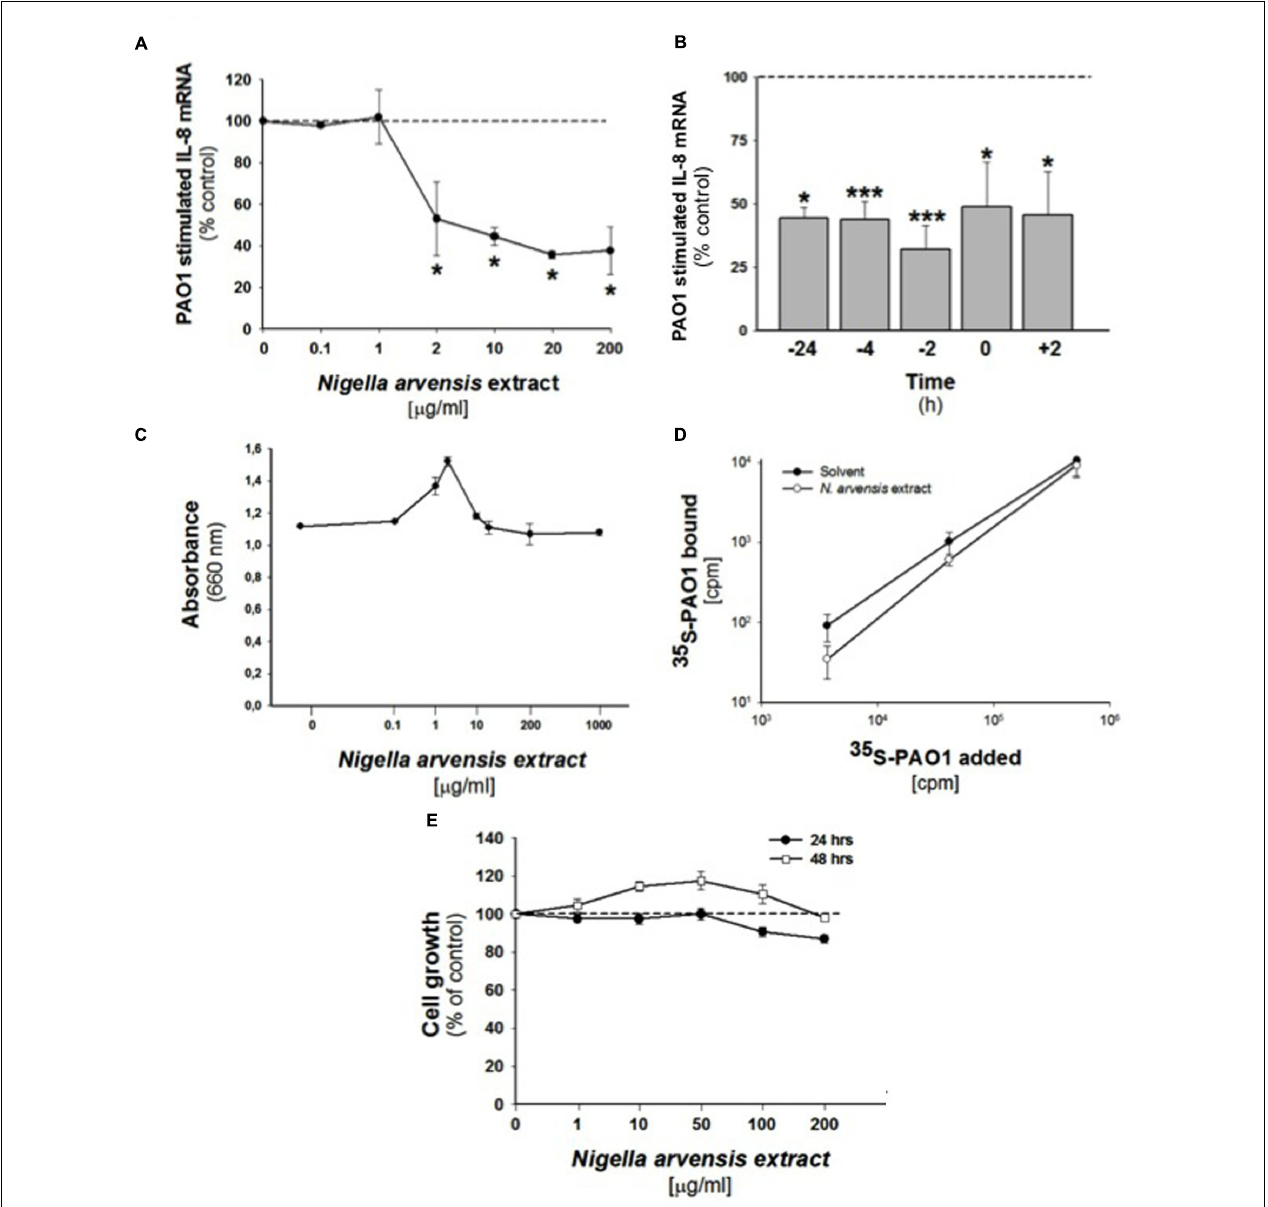
FIGURE 2 | Effect of N. arvensis extracts in IB3-1 cells. (A) Effect of N. arvensis extracts on IL-8 mRNA expression in IB3-1 cells. IB3-1 cells were treated with the chloroform extract (solved in EtOH/DMSO 95/5) (A) at different concentrations (0.1–200 µ g/ml) for 16 h before infection with PAO1 (100 CFU/cell) for further 4 h. IL-8 mRNA expression was quantified by qRT-PCR. Expression of IL-8 mRNA was measured by Real-Time qPCR and obtained by comparing the ratio IL-8 and the housekeeping gene GAPDH between non-infected and infected cells. The results are expressed as the % of untreated cells. Data are mean ± SEM of three independent experiments performed in duplicate. Dashed line corresponds to cells treated with solvent alone. (B) Effect of N. arvensis extract in PAO1 infected IB3-1 cells after different incubation times. The N. arvensis extract (10 µ g/ml) was added to IB3-1 cells 24, 4, and 2 h before, simultaneously or 2 h post PAO1 infection (100 CFU/cell). IL-8 mRNA expression was measured as indicated in (A) . Data are mean ± SEM of three independent experiments performed in duplicate. Dashed line corresponds to cells treated with solvent alone. (C) PAO1 growth. Bacteria were cultured overnight at 37 ◦ C in the presence of solvent or ranging doses (0.1–1000 µ g/ml) of N. arvensis extract. Bacterial growth was monitored by absorbance measures at 660 nm. A representative experiment performed in duplicate is shown. (D) Adhesion of PAO1 to IB3.1 cells. 500,000 IB3-1 cells on Petri dishes, in duplicate, were treated for 24 h with 10 µ g/ml N. arvensis extract. Different amounts of 35 S-PAO1, expressed as CFU/well, were added to the wells and incubated as described in section “Materials and Methods”. Data reported in the figure are the specific binding calculated by subtracting counts obtained in the presence of 100-fold excess of non-labeled PAO1 and are expressed as CFU/well. Data are mean ± SEM of three independent experiments performed in duplicate. (E) Effects of N. arvensis extracts on cell growth in IB3-1 cells. IB3-1 cells were incubated with increasing concentrations (1–200 µ g/ml) of the chloroform extract (solved in EtOH/DMSO) of N. arvensis for 24 and 48 h. Cell viability was measured by cytometer analysis. Data are expressed as % control (solvent) and are relative to a representative experiment performed in duplicate. Dashed line corresponds to cells treated with solvent alone.